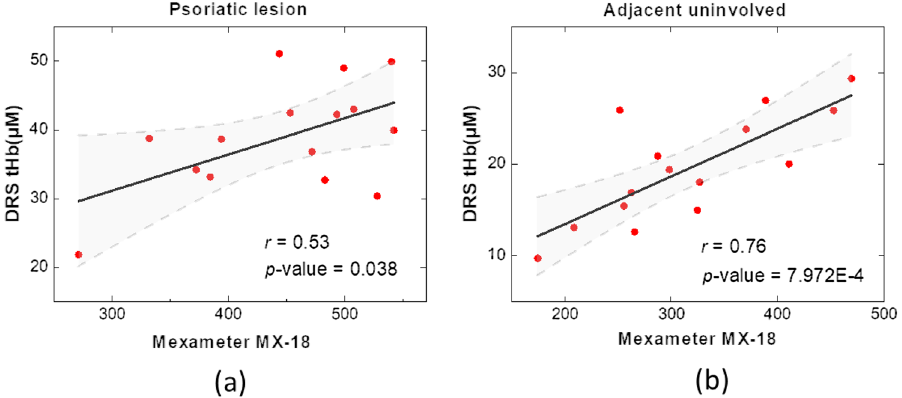
Figure 3. Correlation plots for total hemoglobin values and erythema scores collected from the DRS and Mexameter, respectively, at ( a ) psoriatic lesion and at ( b ) adjacent uninvolved skin. Shaded domain represents